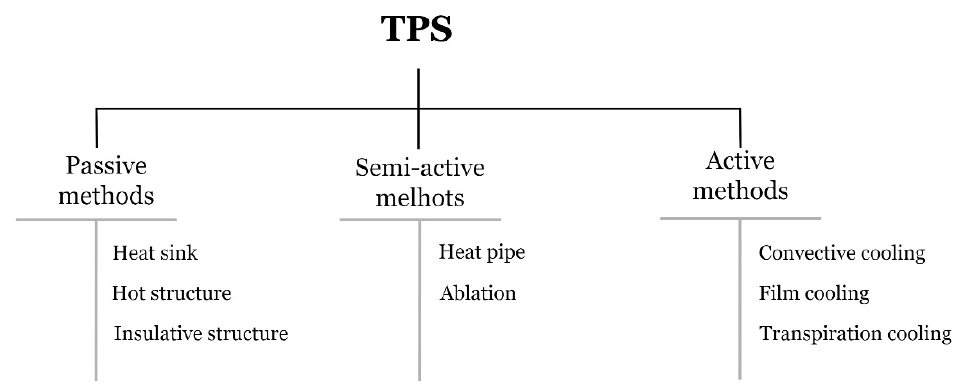
Figure 1. TPS classification based on their working principle and developed structures of each method.